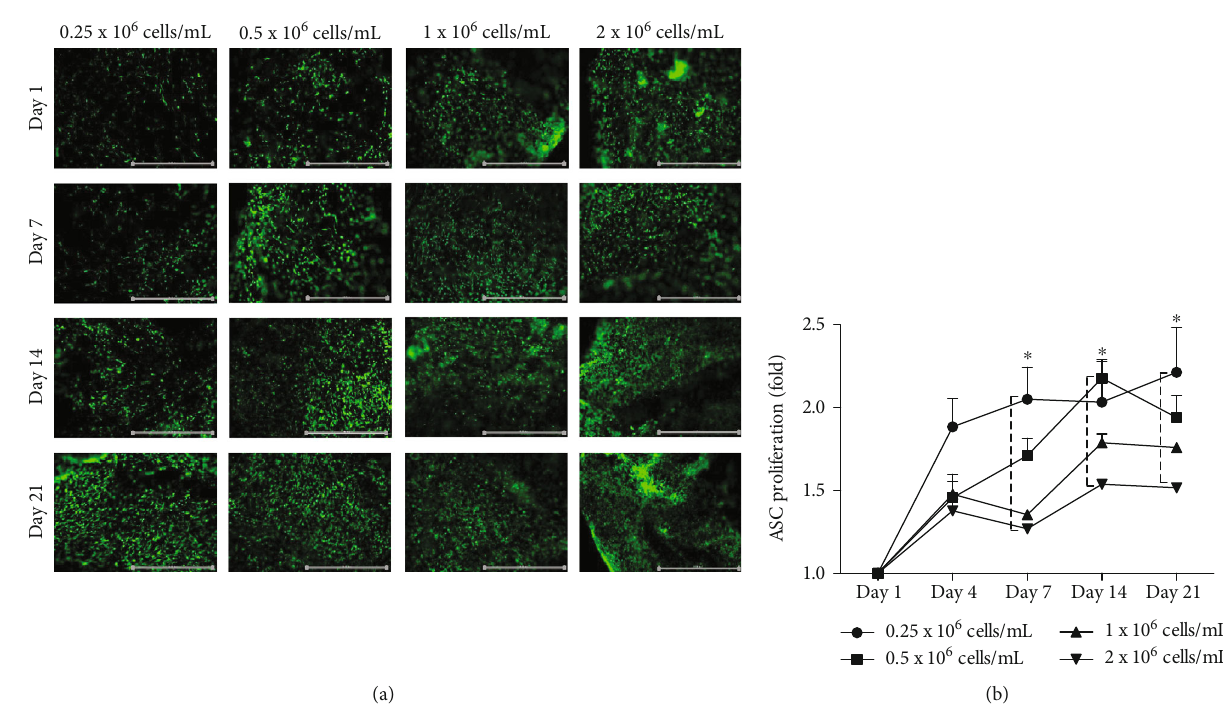
Figure 2: E ff ect of ASC concentration on viability and proliferation in DAT hydrogel. ASCs were seeded in the hydrogels at concentrations of 0 : 25 × 10 6 , 0 : 5 × 10 6 , 1 × 10 6 , and 2 × 10 6 cells/mL and cultured in stromal media. Analysis of viability was performed on day 1 (1 day after seeding), day 4, day 7, day 14, and day 21. (a) Representative images of calcein AM stained viable cells (green); (b) ASC proliferation determined from fl uorescence intensity (reduced alamar blue) for each time point relative to day 1 (fold). Data are expressed as mean ( n = 4 ) ± SD; level of signi fi cance: ( ∗ ) p < 0 : 05 ; Scale bar 1000 μ